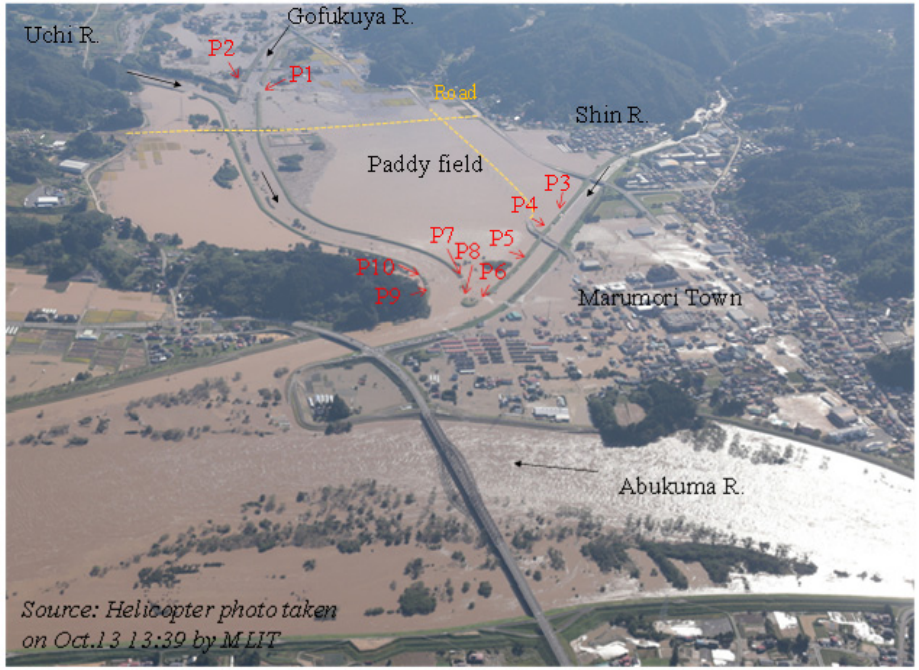
Figure 11. Helicopter photo of the Marumori area on October 13 by MLIT and locations of the levee breaches.